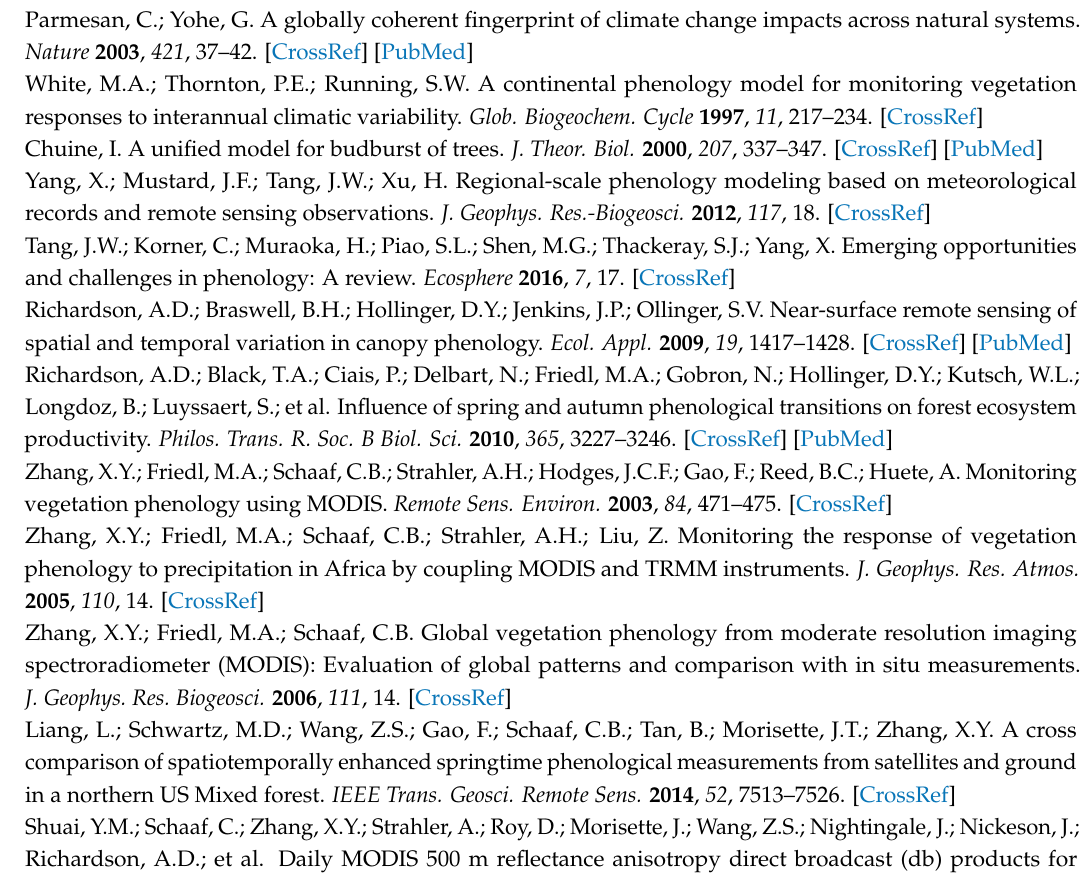
respectively. Table S4: The phenological metrics derived from the ground-based SIF (SIF Ground ) at the Harvard Forest site in 2014 and 2015. S1, S2 and S3 represent the start of spring, middle of spring and end of spring, respectively. A1, A2 and A3 stand for the start of autumn, middle of autumn and end of autumn, respectively. Table S5: The phenological metrics derived from the GOME-2 SIF (SIF GOME-2 ) at the Harvard Forest site during 2007–2015. S1, S2 and S3 represent the start of spring, middle of spring and end of spring, respectively. A1, A2 and A3 stand for the start of autumn, middle of autumn and end of autumn, respectively. Table S6: The phenological metrics derived from gross primary production (GPP) at the Harvard Forest site during 2007–2015. S1, S2 and S3 represent the start of spring, middle of spring and end of spring, respectively. A1, A2 and A3 stand for the start of autumn, middle of autumn and end of autumn,